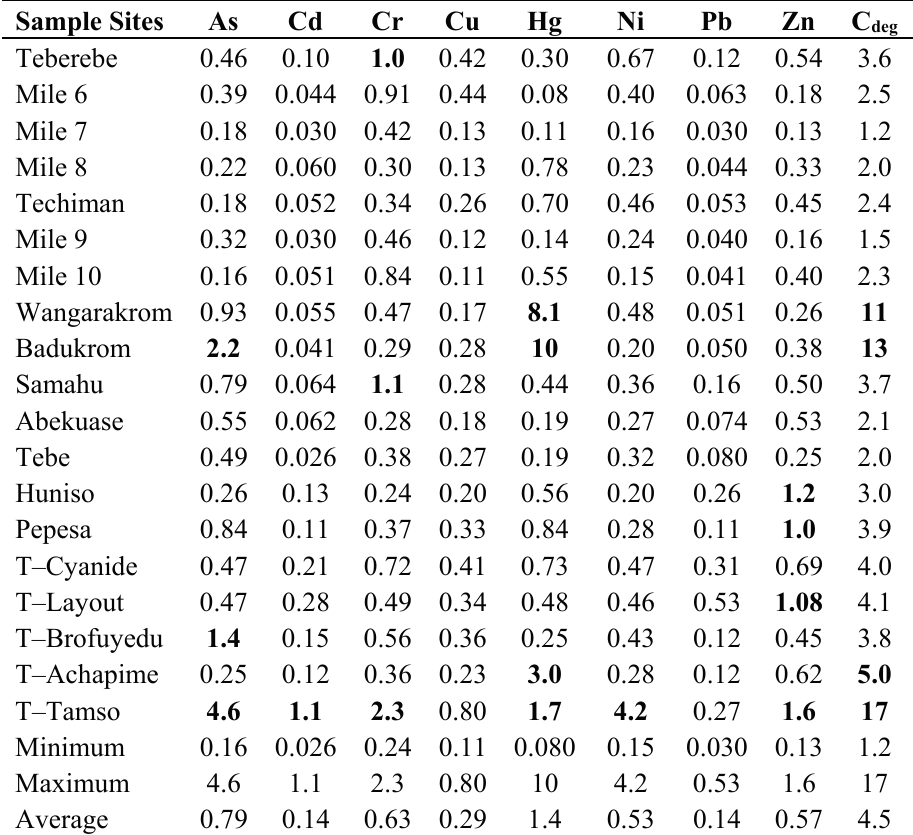
and C deg of heavy metals and a metalloid in surface soils in Table 4. C i f